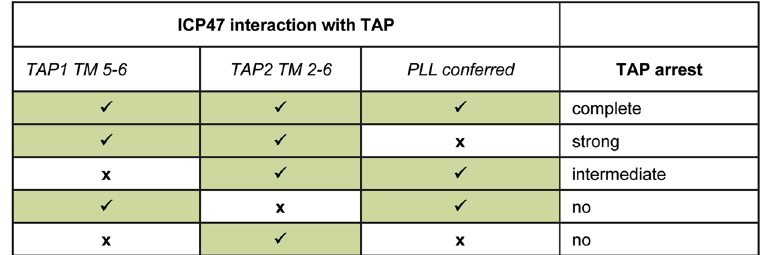
Figure 7. Functional hierarchy of ICP47 interaction sites on TAP. Colored cells indicate that interaction occurs with TAP1 TM5-6, TAP2 TM2-6 or via the 50 PLL 52 motif. Arrest of the TAP complex requires interaction with TAP1, TAP2 and the 50 PLL 52 mediated stabilization. Lack of the 50 PLL 52 motif still allows inhibition (strong) but the TAP cycle cannot be completely blocked and undergoes a delayed progression. If interaction with TAP1 is missing, but interaction sites on TAP2 are present in combination with the 50 PLL 52 sequence, TAP is blocked with an intermediate efficiency. Lack of TAP2 interaction, or of TAP1 and 50 PLL 52 simultaneously, leads to loss of